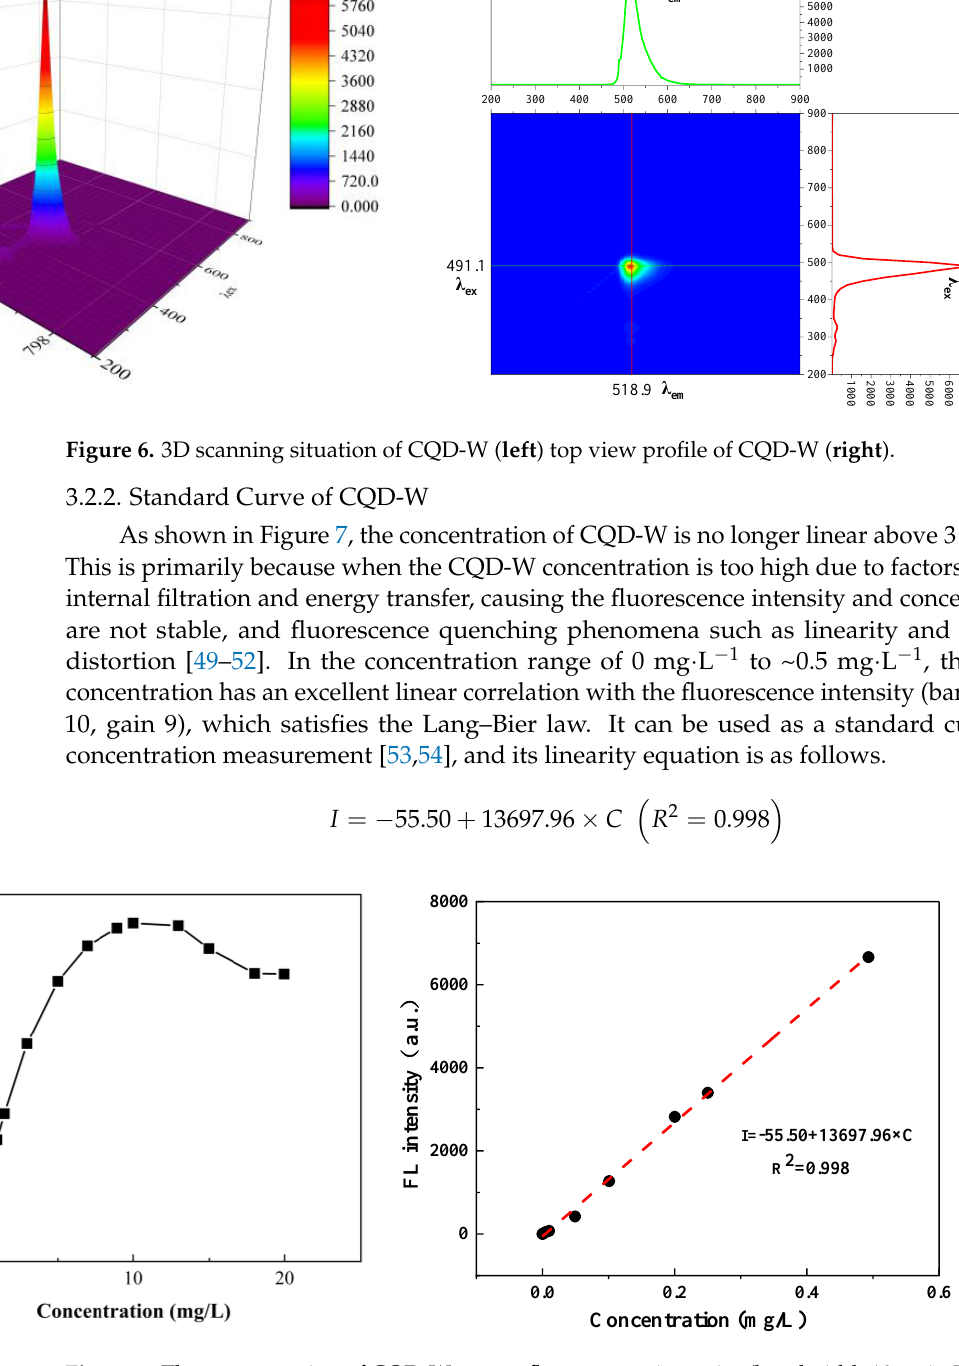
Figure 7. The concentration of CQD-W versus fluorescence intensity (bandwidth 10, gain 7).